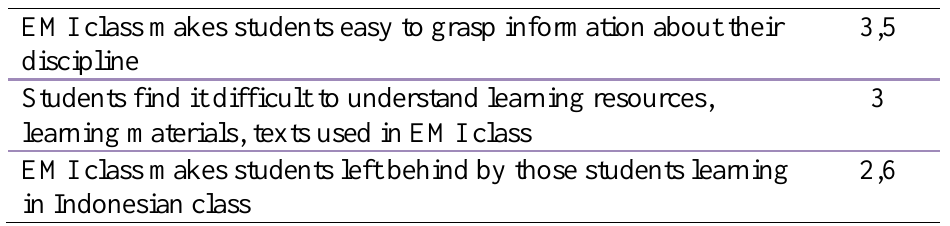
Table 3.The perceptions of students on